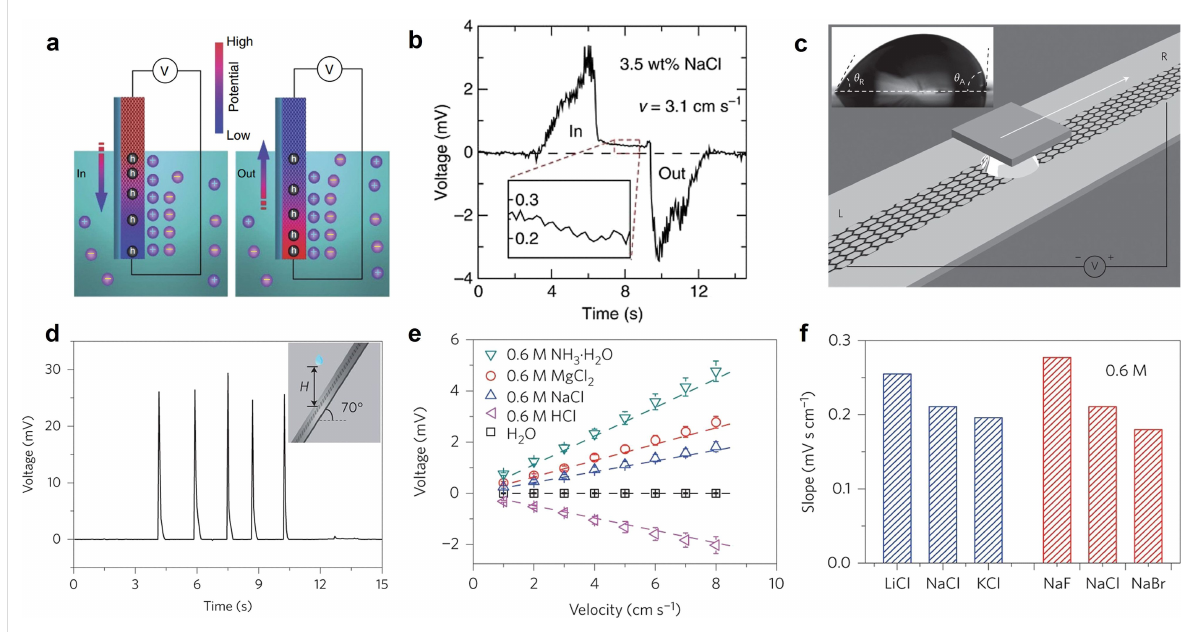
Figure 2: (a) Schematic diagrams of the single-layer graphene device and wave energy harvesting. (b) The voltage signal produced by inserting and withdrawing the sample at v = 3.1 cm/s in 0.6 M NaCl (3.5 wt %) solution. Figure 2a and Figure 2b are from [45] and were reprinted by permission from Springer Nature from the journal Nature Communications (“Waving potential in graphene“ by J. Yin; Z. Zhang; X. Li; J. Yu; J. Zhou; Y. Chen; W. Guo), Copyright 2014 Springer Nature. This content is not subject to CC BY 4.0. (c) A liquid droplet is sandwiched between graphene and a SiO 2 / Si wafer and is drawn at specific velocities by the wafer. (d) A pulse voltage is generated by continuously falling droplets. (e) Voltage induced by three droplets of different solutions. (f) Fitted slope A = V / v ( V of voltage, v of velocity) for three droplets of different chloride and sodium salts. Figure 2c–f are from [8] and were reprinted by permission from Springer Nature from the journal Nature Nanotechnology (“Generating electricity by moving a droplet of ionic liquid along graphene“ by J. Yin; X. Li; J. Yu; Z. Zhang; J. Zhou; W. Guo), Copyright 2014 Springer Nature. This content is not subject to CC BY 4.0.